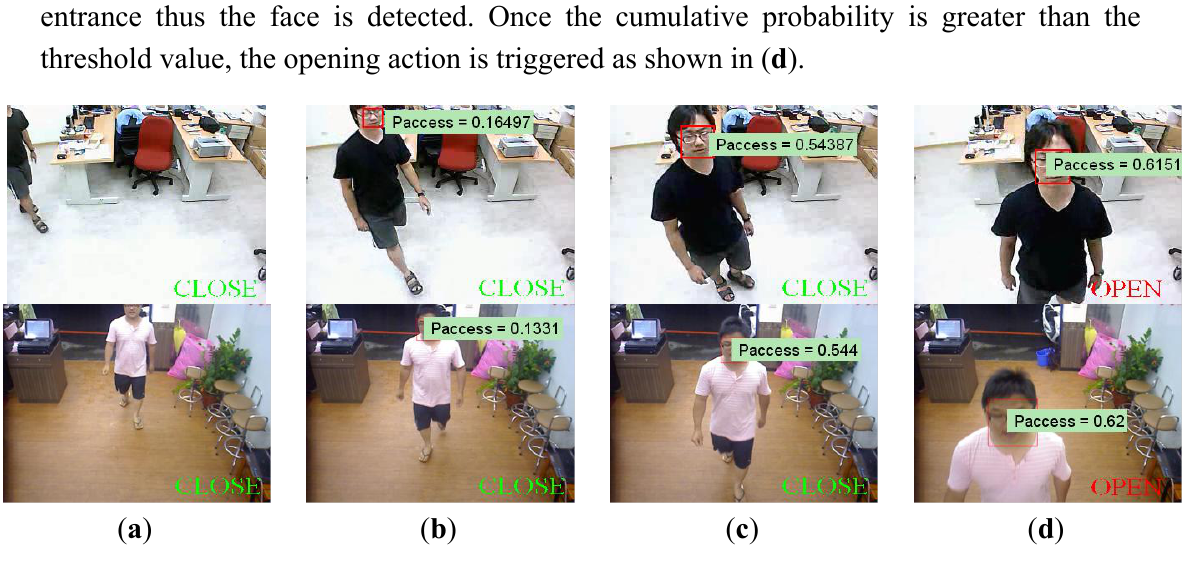
Figure 7. Opening activated by multiple persons in lab and restaurant: The cumulative probability values for all detected faces are calculated independently. Thus, as long as one of the cumulative probability values exceeds the threshold, the door will be opened as in ( d